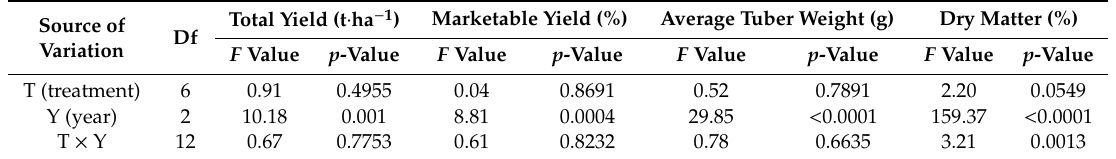
Table 4. Summary of analysis of variance of yield and dry matter of potato tubers.